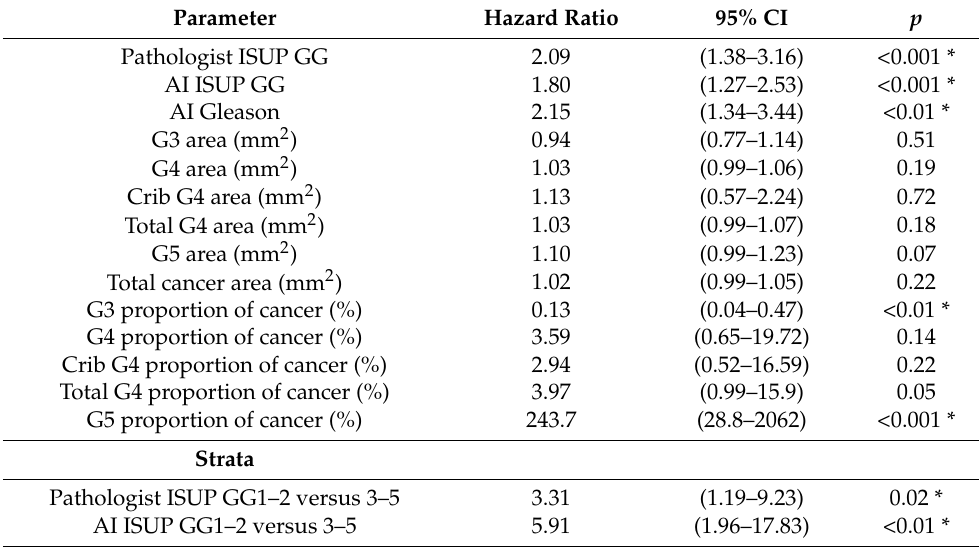
Table 10. Cox proportional-hazard regression